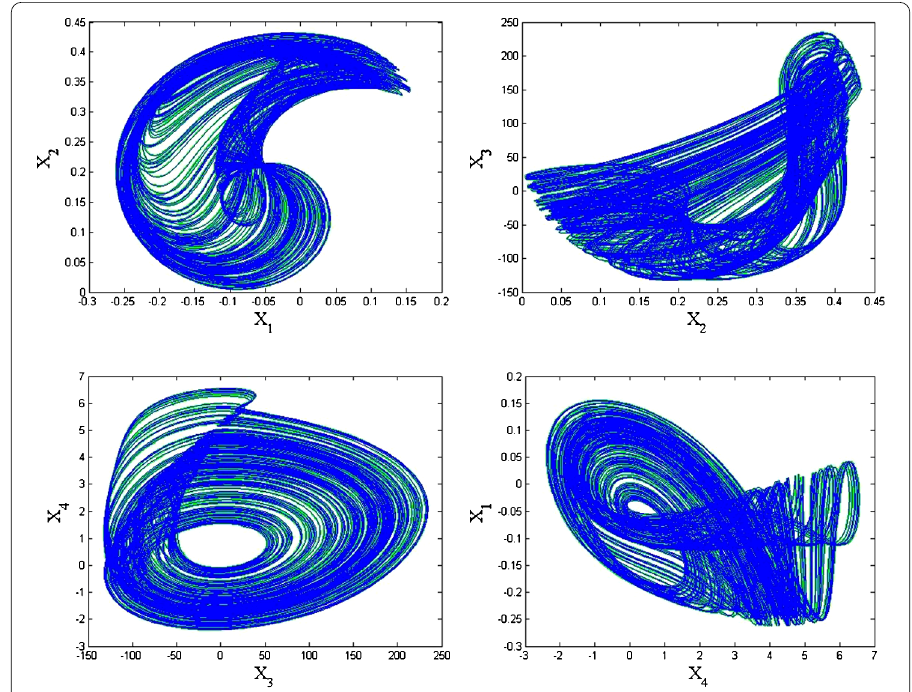
Figure 1 2-D state portraits of the fractional-order induction